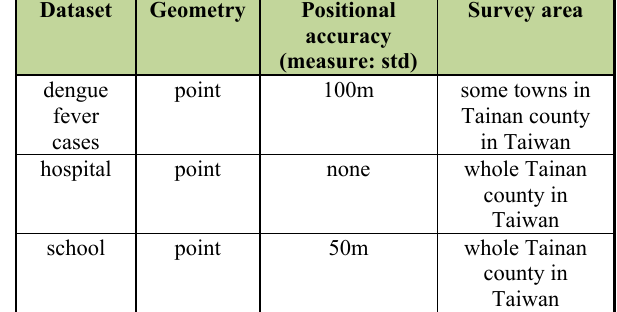
Table 2. Datasets used in the